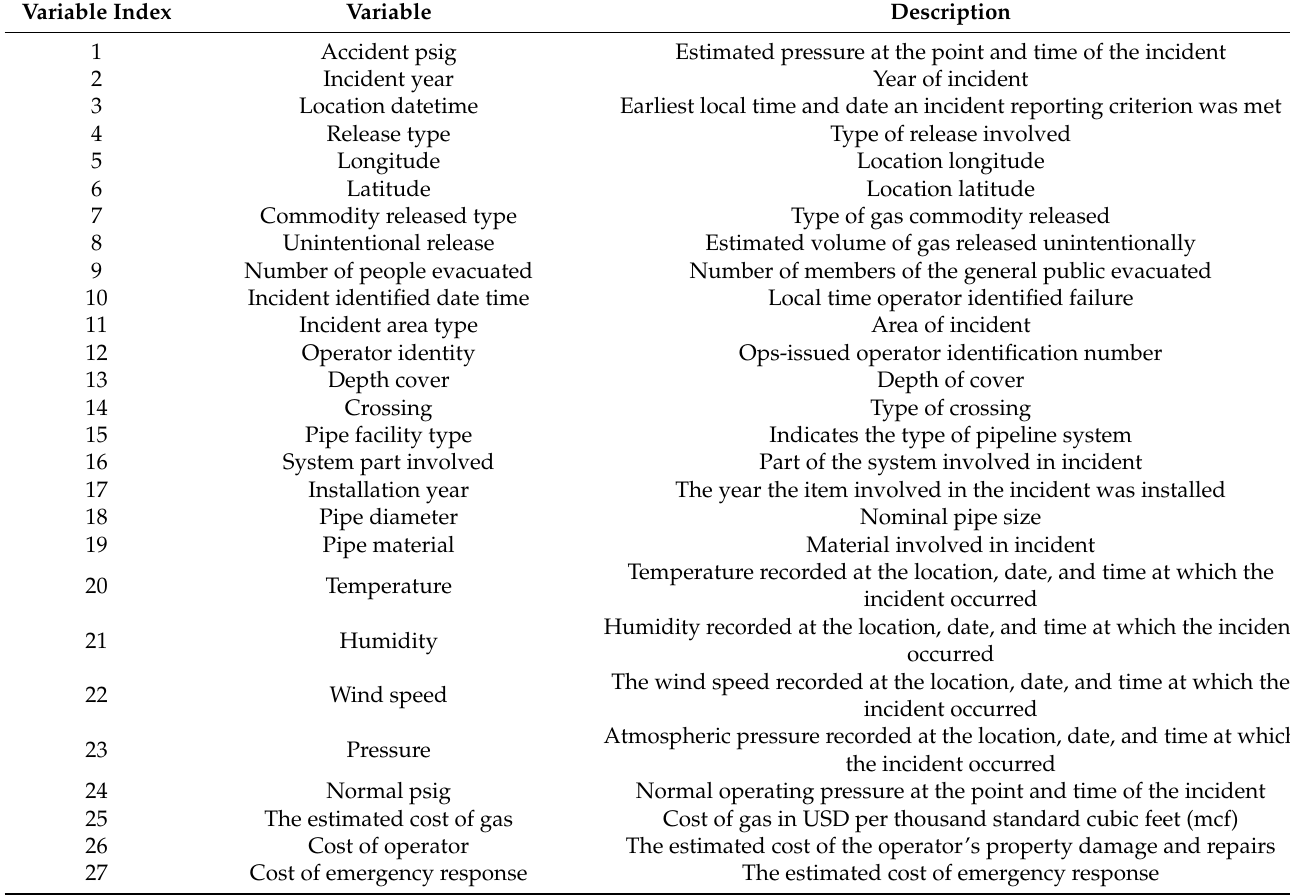
Table 2. Sample of variables influencing pipeline damage